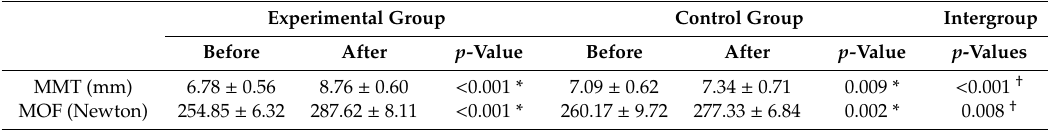
Table 3. Changes of masseter muscle thickness and maximum occlusal force in parameters before and after treatment. Experimental Group Control Group Intergroup Before After p- Value Before After p- Value p -Values MMT (mm) 6.78 ± 0.56 8.76 ± 0.60 < 0.001 * 7.09 ± 0.62 7.34 ± 0.71 0.009 * < 0.001 † MOF (Newton) 254.85 ± 6.32 287.62 ± 8.11 260.17 ± 9.72